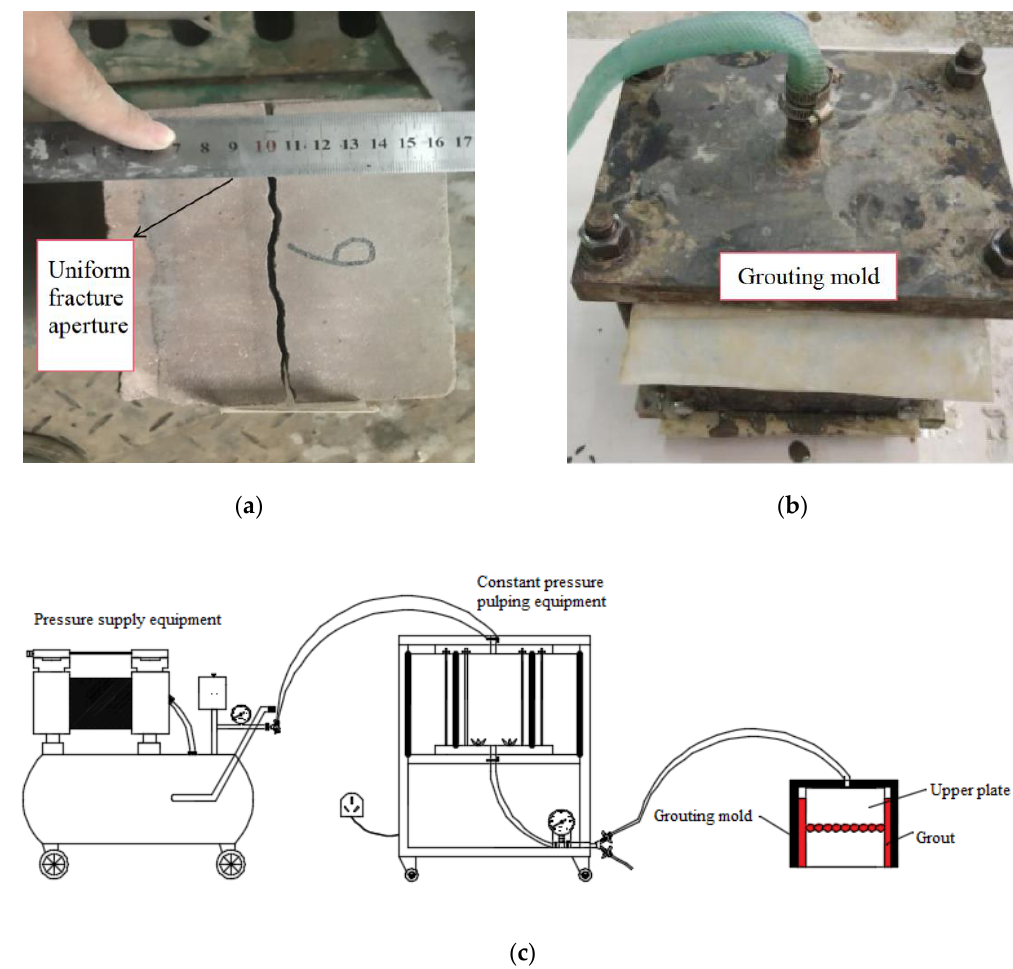
Figure 3. Grouting of a rock fracture specimen: ( a ) consistent aperture of fracture, ( b ) grouting test, and ( c ) the self-developed grouting equipment.